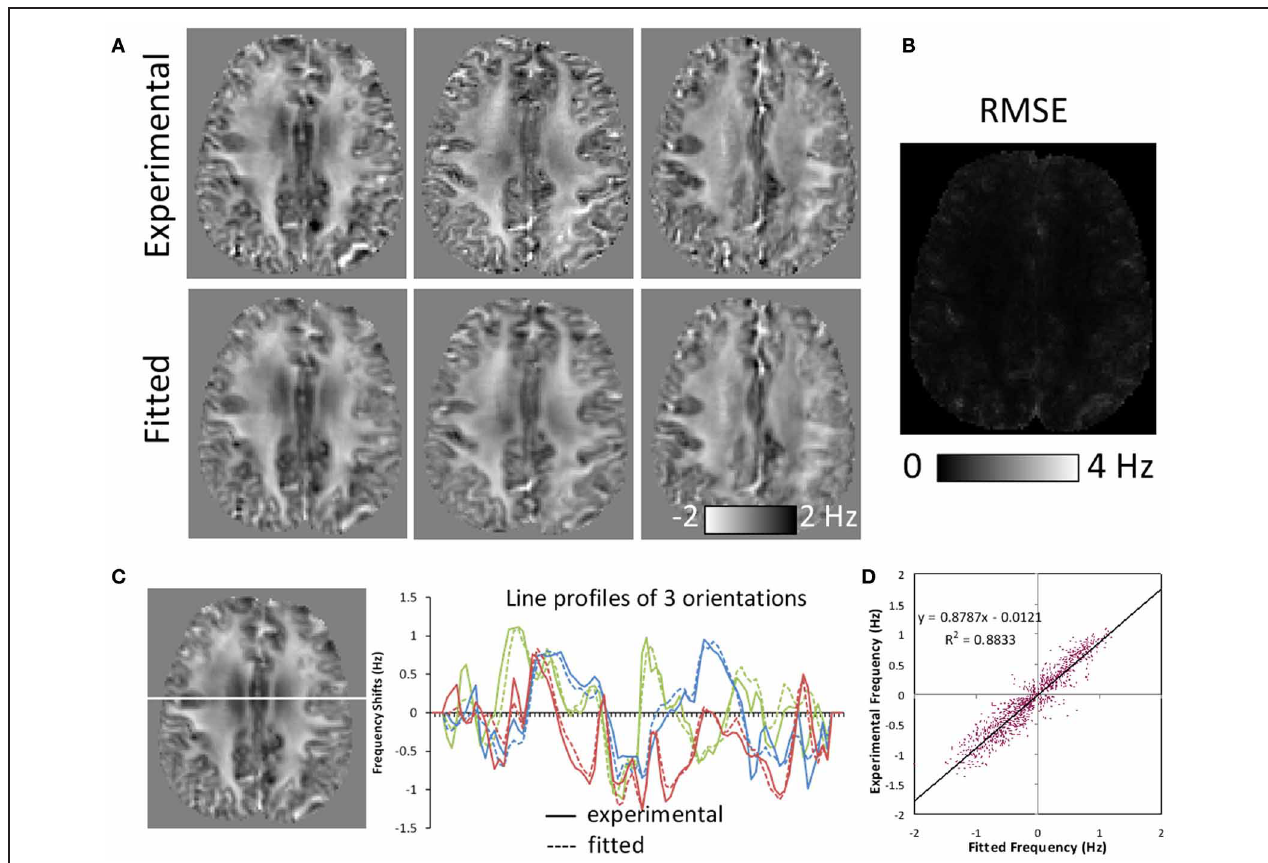
FIGURE 4 | Comparison of frequency maps measured experimentally and those fitted with susceptibility tensors. (A) Comparison of representative experimental and fitted frequency maps along three orientations. Fitted maps were slightly smoothed but showing similar contrast. (B) A representative root-mean-squared-error (RMSE) map between